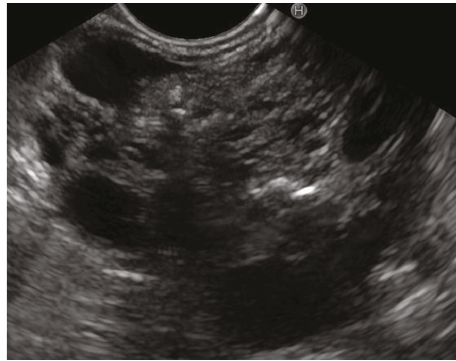
Figure 5: Serous cystic neoplasm with micro- and